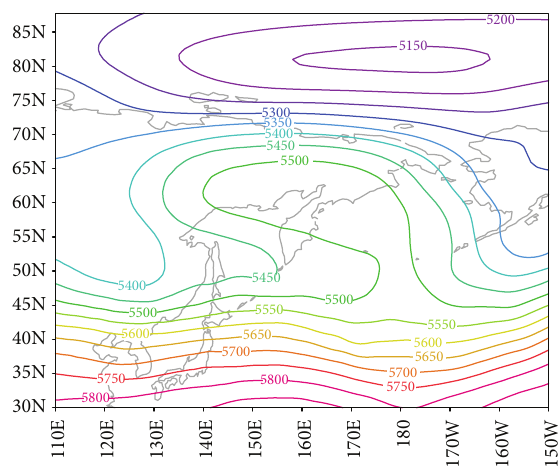
Figure 1: ERA-Interim reanalysis time-averaged geopotential heights for October 11–19, 2012.